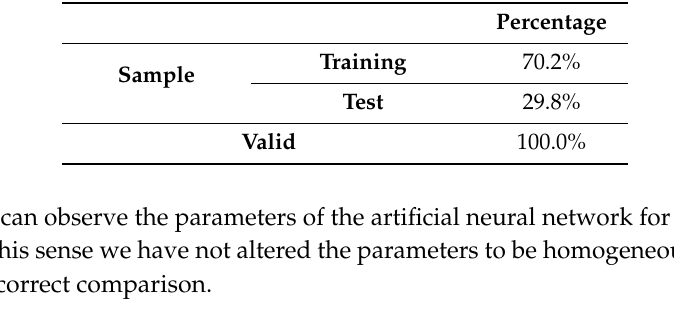
Table 4. Case allocation summary for Value.